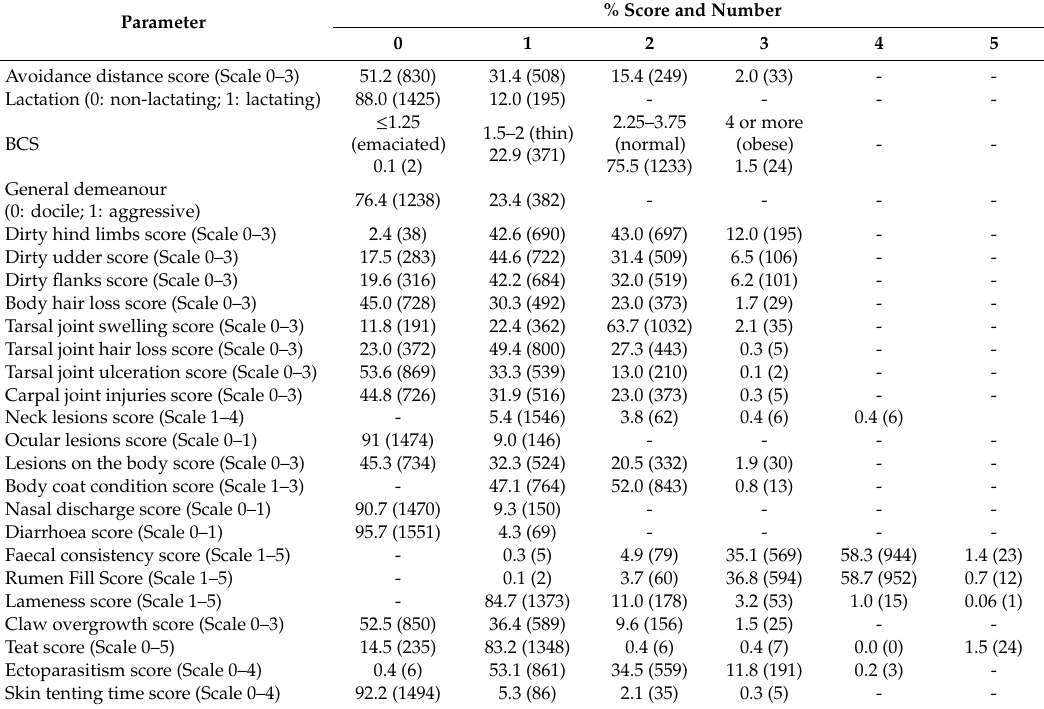
Table 1. Distribution of di ff erent cow-based welfare parameters in 54 cow shelters ( n = 1620).